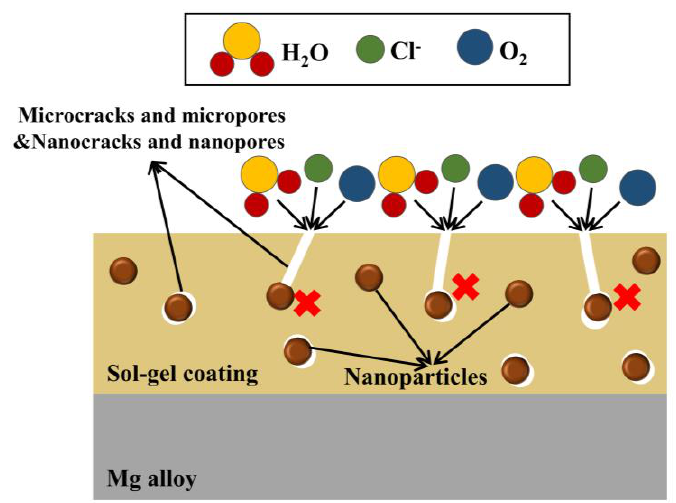
Figure 5. The schematic diagram of sol-gel coatings containing nanoparticles.